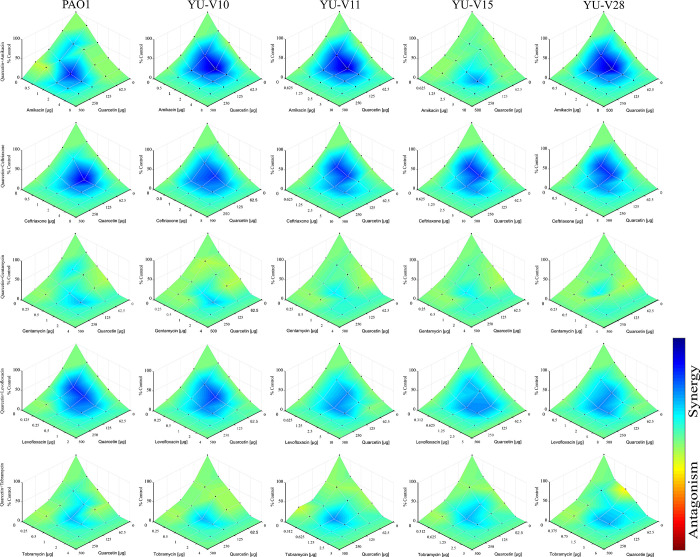
Combenefit mapped surface HSA plot.The data based on the OD600 values obtained for antibiotic-quercetin combination from the 24 h incubation was used to generate this heat map. Light blue to dark blue shows increased reduction (synergy) while yellow-red shows no reduction (non-synergy).